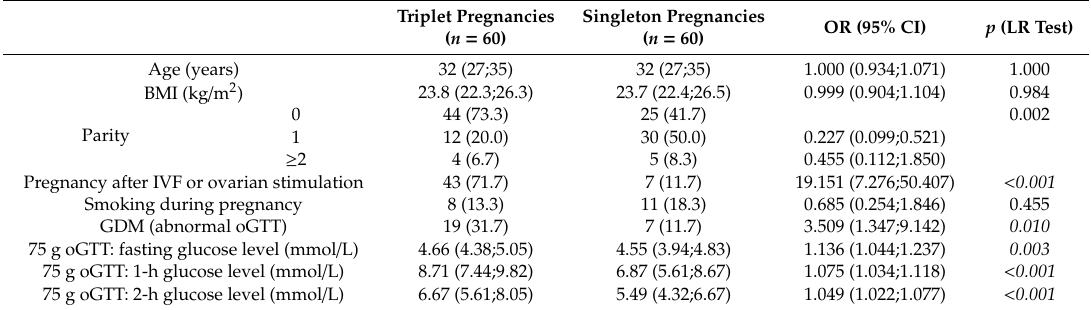
Table 1. Triplet compared to age- and BMI-matched singleton pregnancies: basic patient characteristics and outcomes concerning gestational diabetes mellitus (GDM).